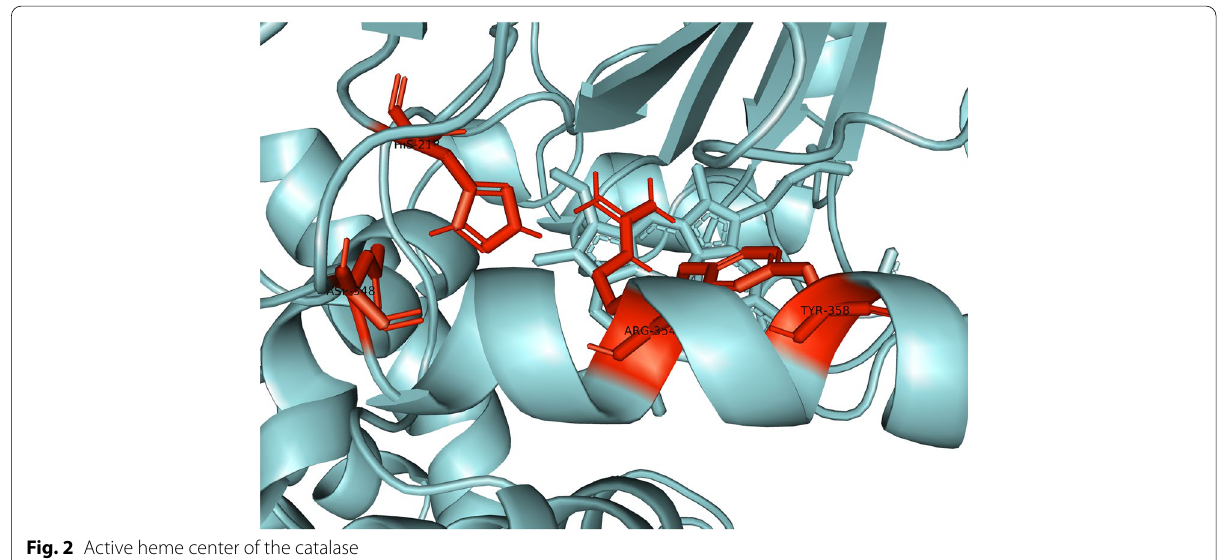
Fig. 2 Active heme center of the catalase